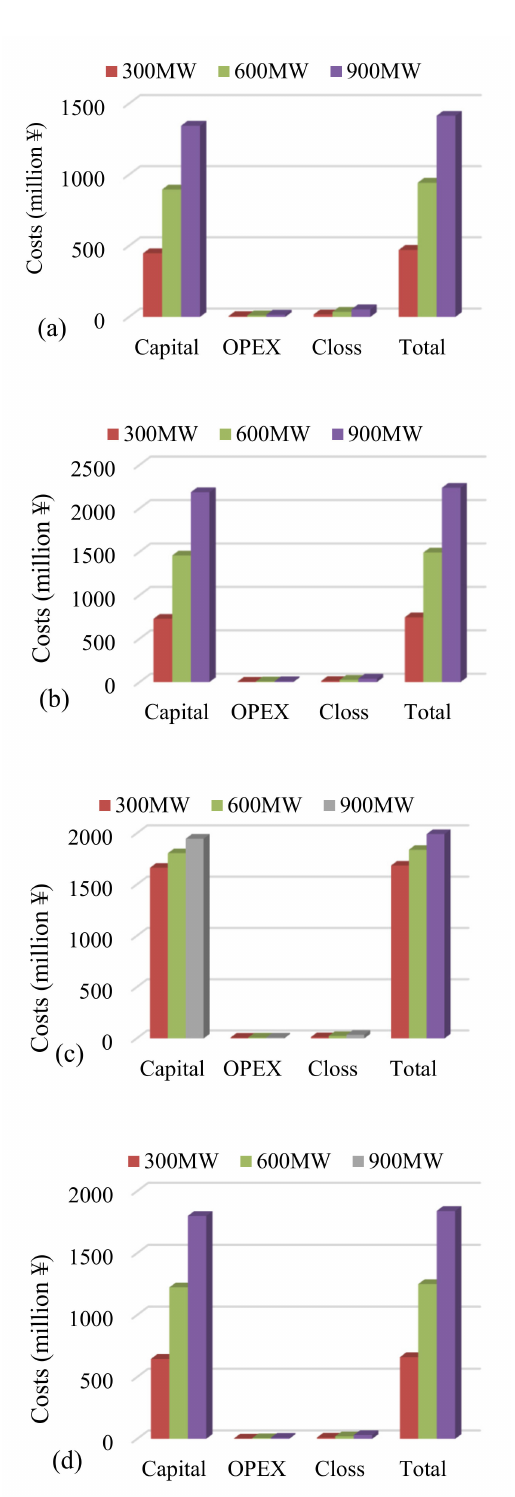
Figure 6. Costs components comparisons with different P ( L is 25 km): ( a ) shows the HVAC system; ( b ) shows the VSC-HVDC system; ( c ) shows the GIL system; ( d ) shows the Hybrid HVDC